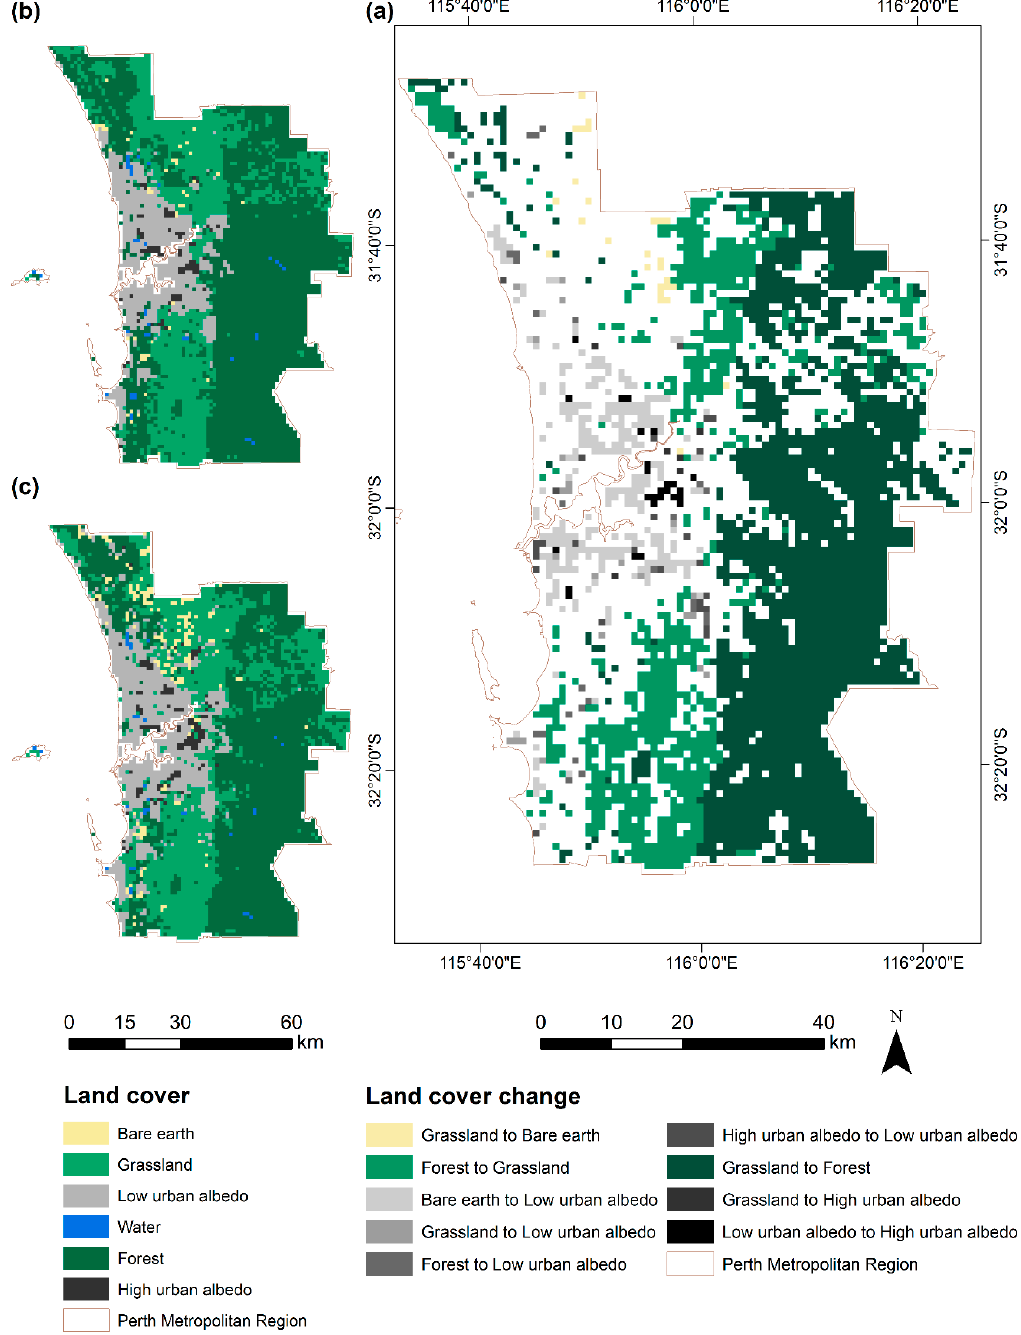
Figure 2. Land cover change meeting the criteria of (1) greater than all other changes within a MODIS pixel and (2) the change to land cover dominates (>50%) the 2013 MODIS pixel. Change is derived between 2003 and 2013 from classified Landsat data aggregated to MODIS resolution, where white pixels do not meet the criteria ( a ), alongside static land cover maps from 2003 ( b ) and 2013 ( c ).